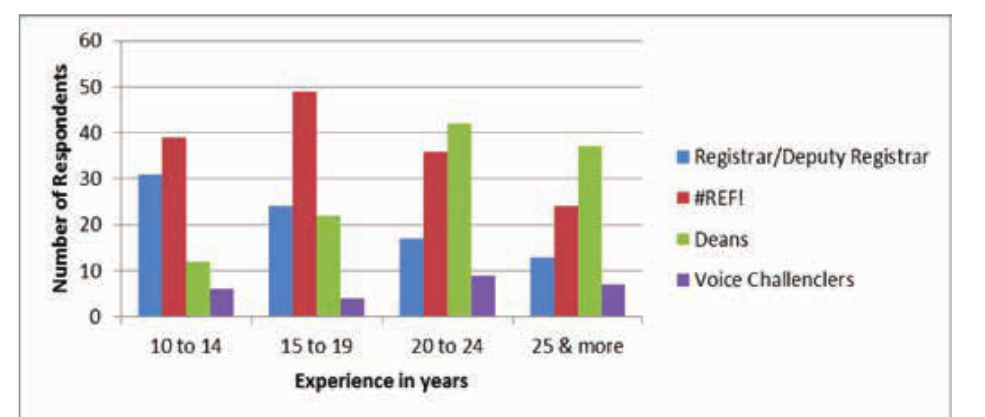
Figure 3: Number of respondents according to the demographic